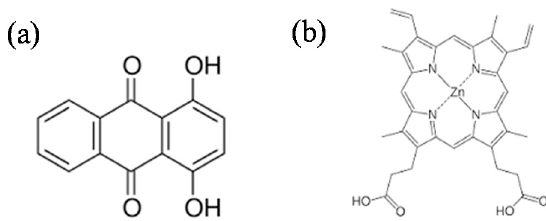
Figure 1. The molecular structure of organic dyes used in the present work as photocatalysts sensitizers. ( a ) Quinizarin and ( b ) Zinc protoporphyrin.